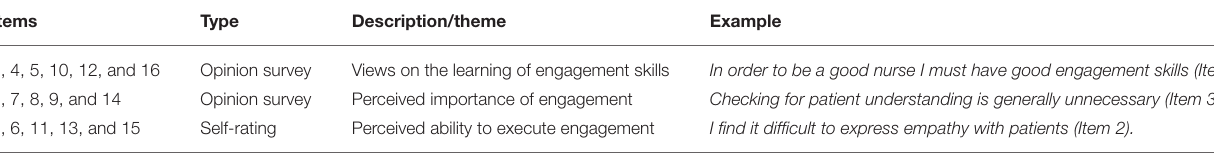
TABLE 3 | Summary of questionnaire items in NEPS. Items